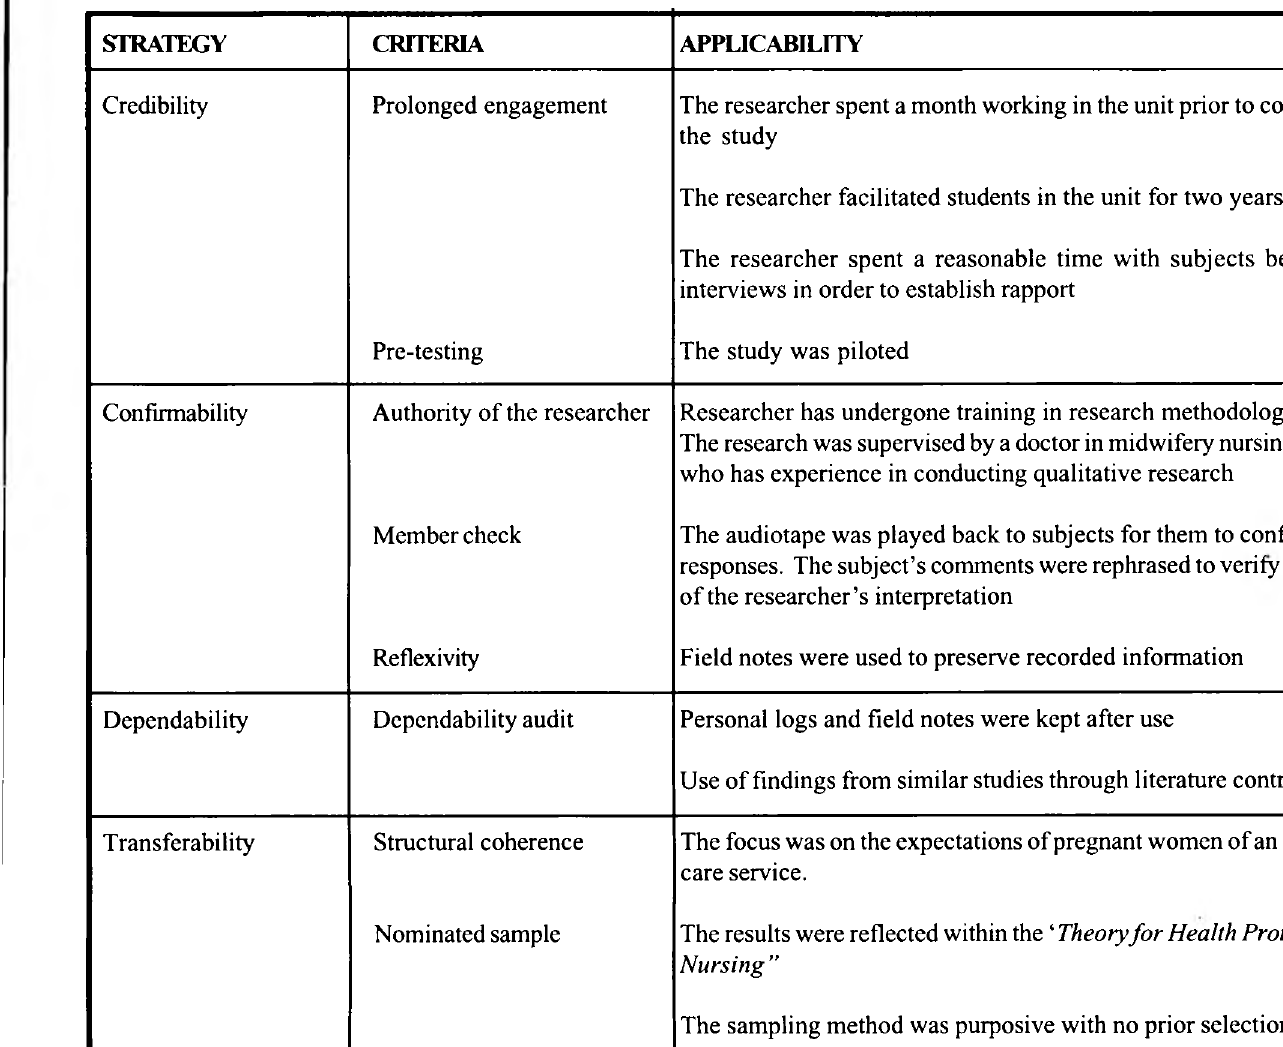
Tablel: Measures used to ensure trustworthiness of the study